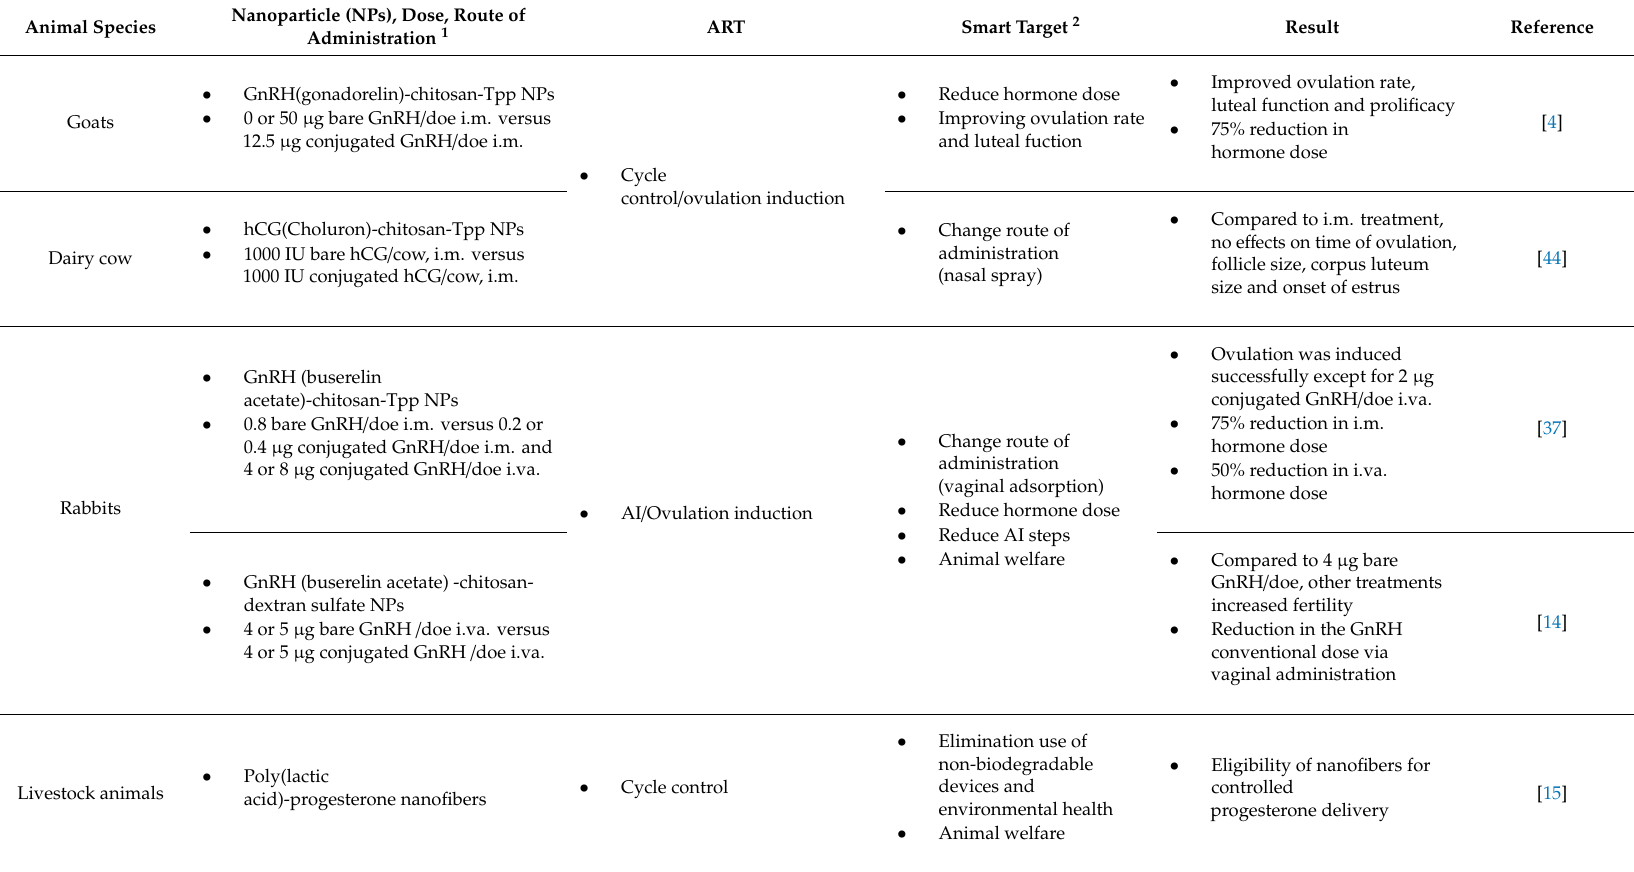
Table 2. Summary of previous research connecting nanotechnology and female